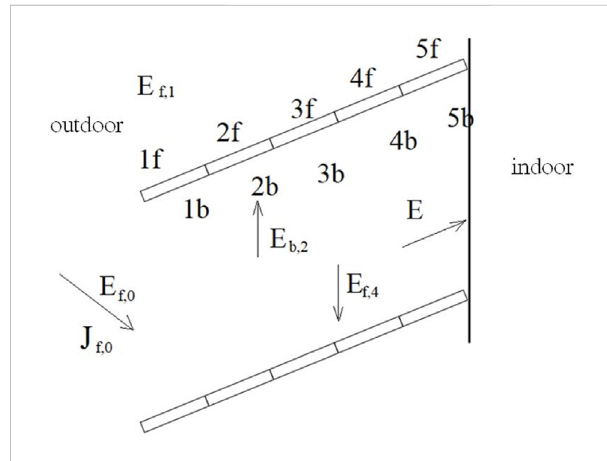
FIGURE 3 Diagram of divided slat regions for PCM blind (Li,